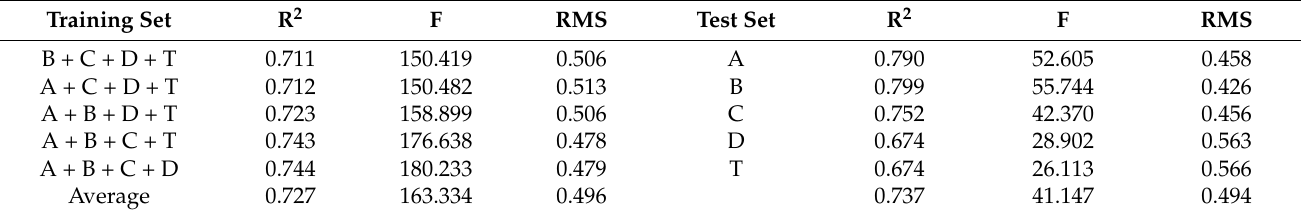
Table 7. Validation of the MLR model.